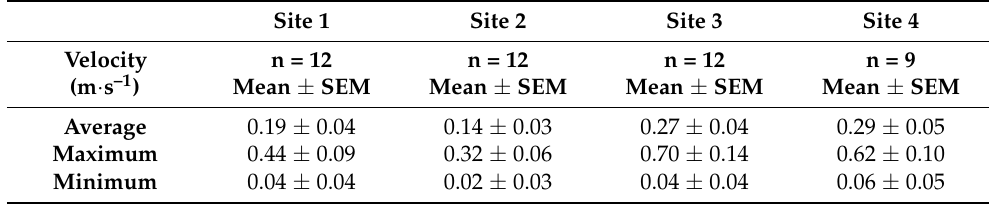
Table 3. Resulted mean current velocities measured for the macrozoobenthic samples from each